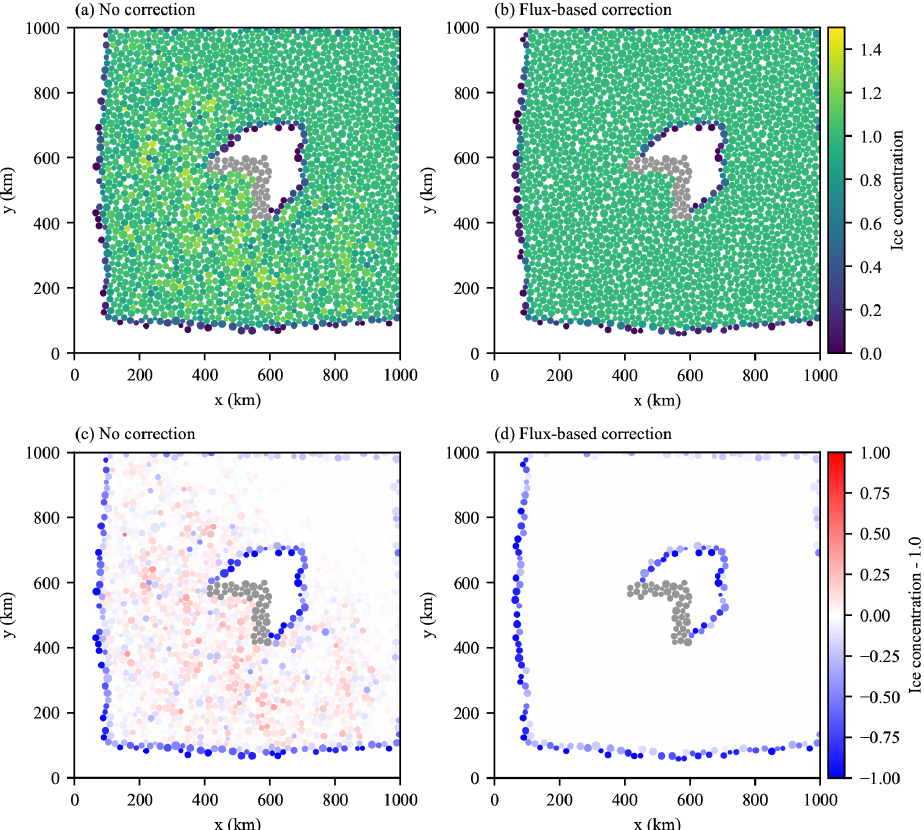
Figure 11. Island test case showing remapping without any correction (a, c) and with the flux-based correction (b, d) . (a, b) Ice concentration and (c, d) the difference from an ice concentration of 1.0. Coastal elements comprising the central island are shown in